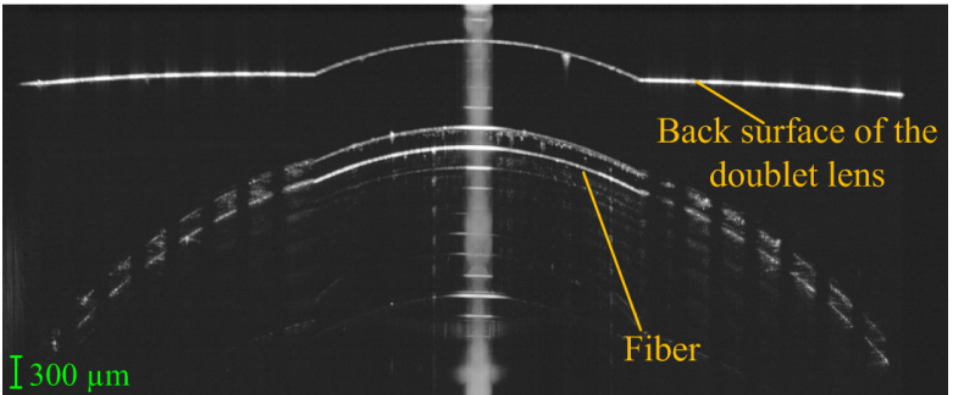
Figure 8. OCT B-scan acquired using the eye model of Wang et al. Journal of Innovative Optical Health Sciences 2021, 14, 2150010 ([72]). Originally published by and reprinted with permission fromWorld Scientific.